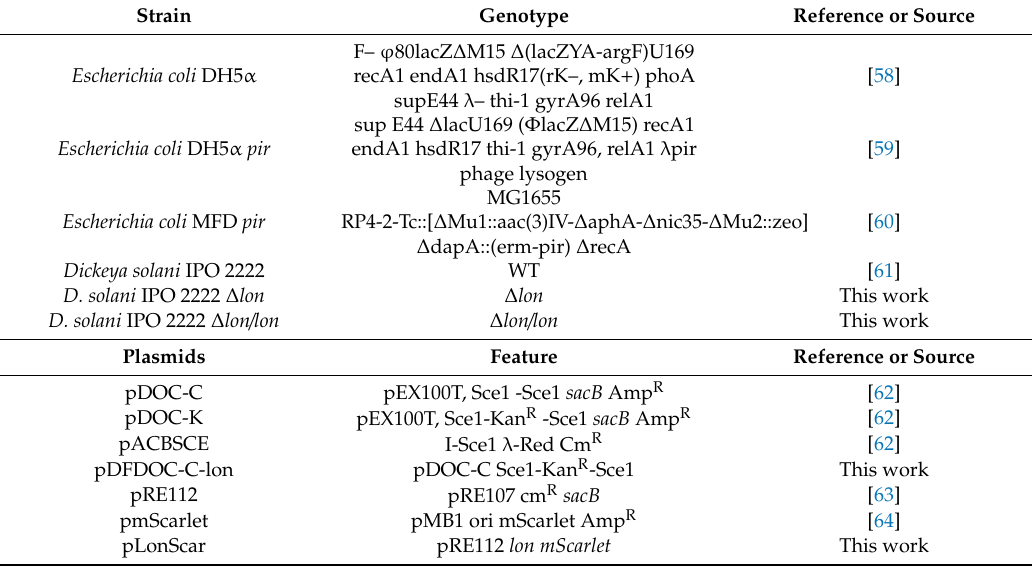
Table 2. Bacterial strains and plasmids used in this